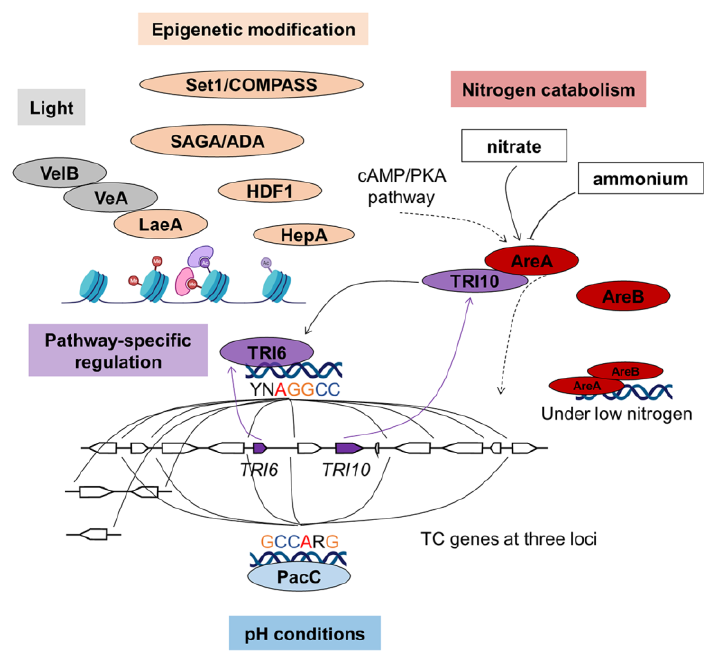
Figure 5. Regulatory mechanism of TC biosynthesis.